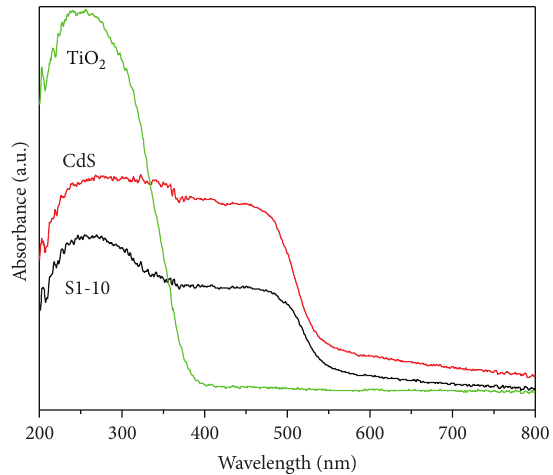
Figure 8: Photoluminescence (PL) spectra of CdS and S1-10: 10 wt% TiO 2 /CdS (10h).